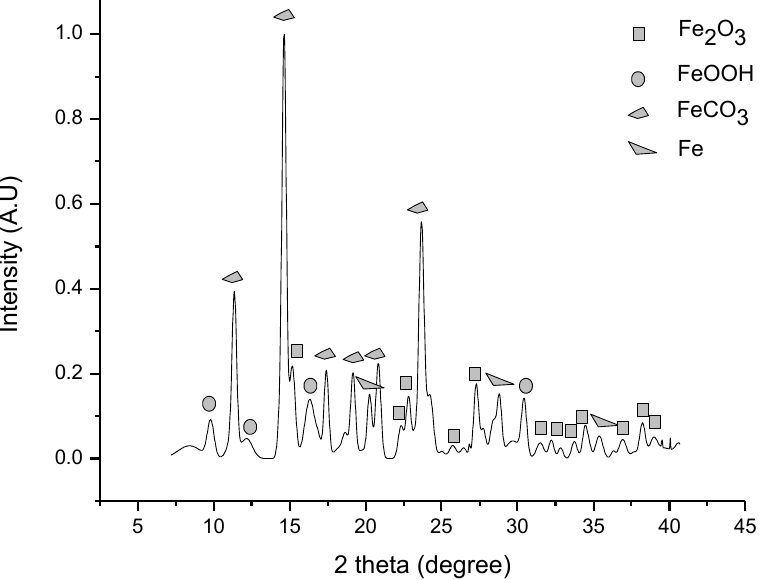
Figure 5. Carbonation of iron ore in the thermo pressure process at 50 bar, 100 °C, and 4 h of time reaction.